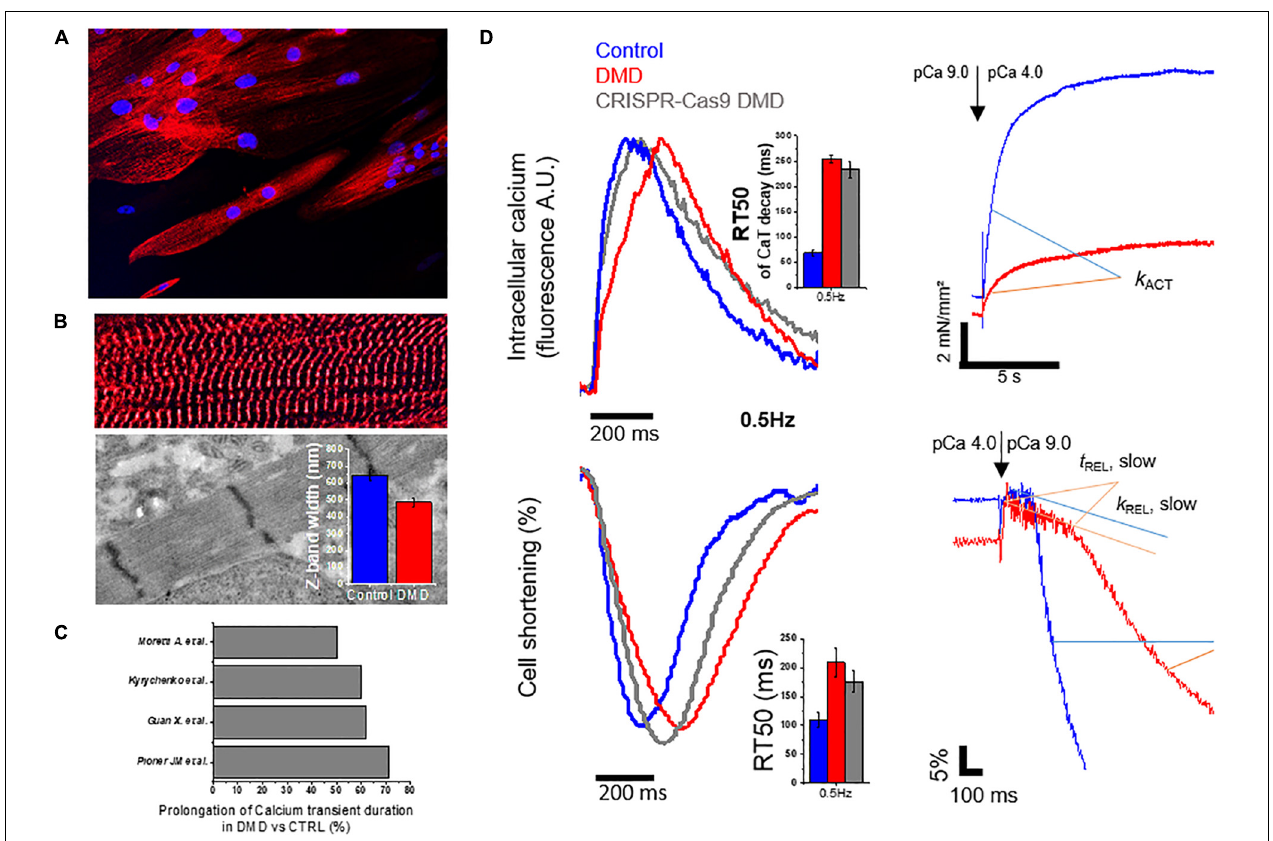
FIGURE 4 | Morphology and function altered in DMD-hiPSC-CMs from patient confirmed in a CRISPR-Cas9 gene edited cell line. Original data are modified from Pioner et al. (2019b) with the correct permission from the owner (Pioner et al., 2019a). A DMD-hiPSC-cell line from a patient (with (cid:49) Exon 50 in DMD gene) and a CRISPR-Cas9 gene edited cell line (c.263 (cid:49) G) targeting Exon 1 in healthy control cell line (Control) were generated and the cardiomyocytes were matured onto nanotopographic cues for 3 months. (A) DMD-hiPSC-CMs displayed aspect ratio similar to adult cardiomyocytes and Z-bands were observed across the entire cell width (diameter), suggesting DMD-CMs experienced hypertrophy and a greater number of myofibrils in parallel. (B) Despite similar myofibril alignment to control-hiPSC-CMs, sarcomere diameters (estimated from the length of Z-bands by transmitted electron microscopy) were significantly smaller, suggesting a possible reduction in the parallel assembly of myofilaments within individual myofibrils. (C) Meta-analysis on Calcium transient duration. (D) Representative traces of calcium transients (CaT), cell shortening and myofibril mechanics of DMD-hiPSC-CMs compared to controls. Simultaneous recordings at single cell level revealed slower CaT decay (estimated from time to peak to 50% of CaT decay, RT50, ms), slower cell relaxation (RT50, ms) at 37 ◦ C and external pacing (0.5 Hz reported). Compared to other studies reporting similar analysis of calcium transients, slower CaT duration might be a peculiarity of DMD-hiPSC-CMs. Single myofibrils showed lower isometric-tension generating capacity and slower myofibril relaxation (slow t REL and fast k REL ). This study concluded that both calcium handling and myofibril abnormalities may contribute to prolong cell